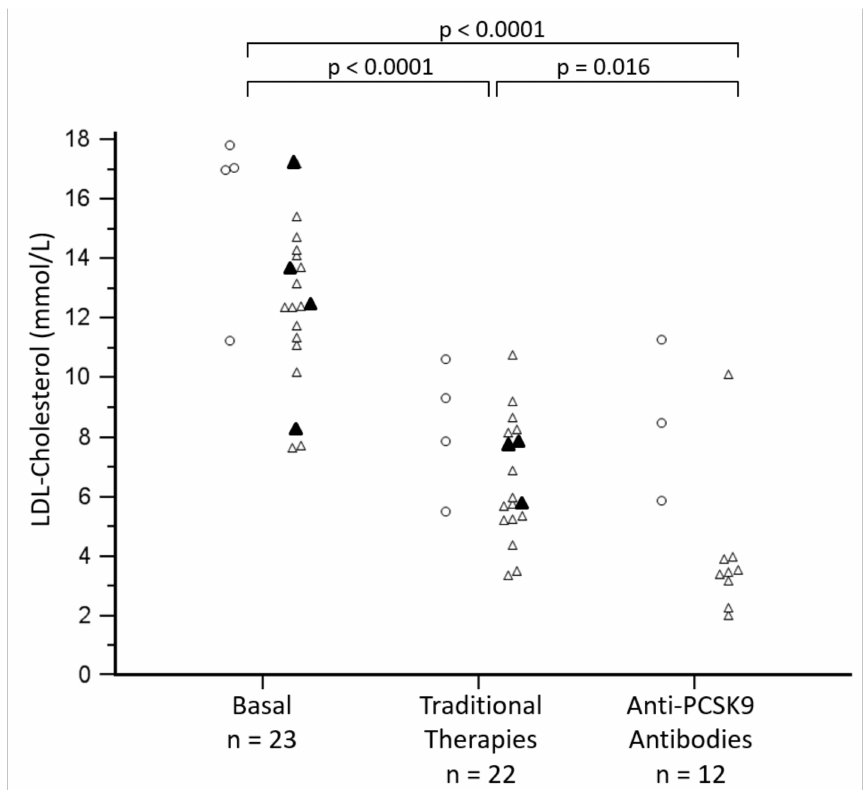
Figure 2. Lipid levels before and after therapy in homozygous patients. LDL-cholesterol levels in mmol / L before therapy, after traditional therapy (statin therapy plus ezetimibe in adults, or cholestyramine in three children) and after innovative therapies (lomitapide or anti- PCSK9 antibodies) are reported. Open circles indicate the homozygous patients (all adults), whereas triangles indicate compound heterozygous patients (open triangles indicate the adults and black ones indicate the children). Statistical significances were evaluated by paired t